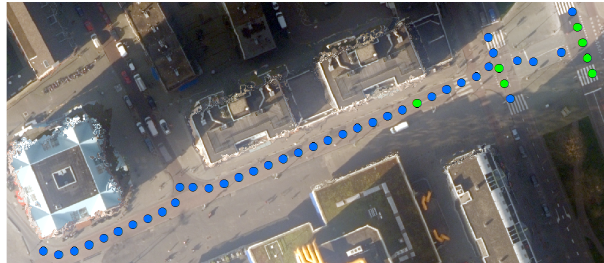
Figure 4. Test area 1; green: recording locations with correspondences to the aerial images; blue: recording locations without correspondences